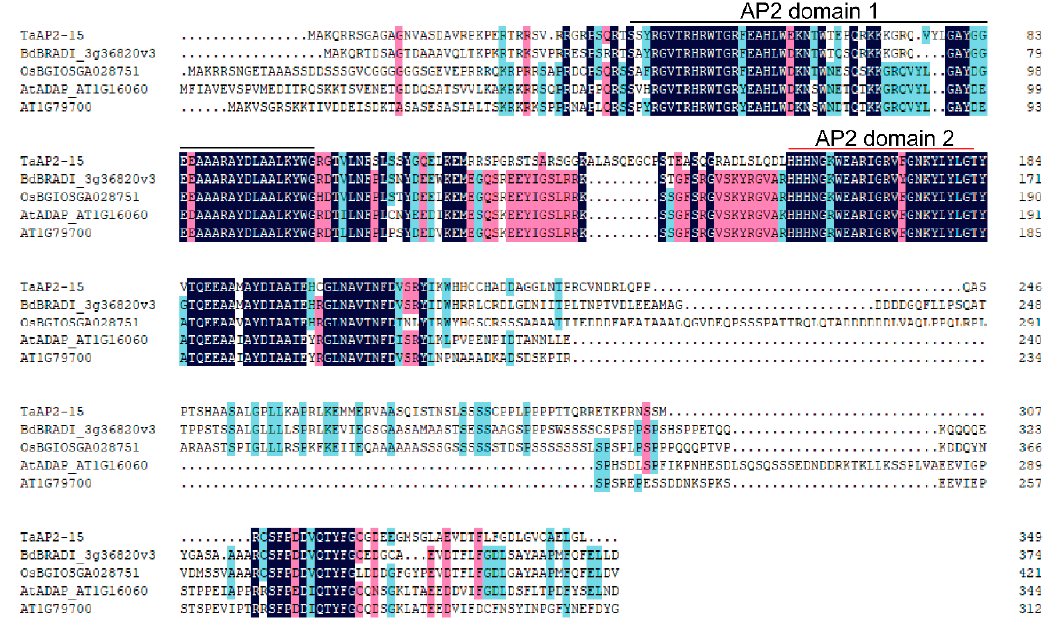
Figure 1. Multisequence alignment of TaAP2-15 with its orthologs in other plant species. Comparison of amino acid sequences of Triticum aestivum ( TaAP2-15 ), with its orthologs from Brachypodium distachyon (BRADI_3g36820v3), Oryza sativum (BGIOSGA028751) and Arabidopsis thaliana (AT1G16060 and AT1G79700). Conserved residues through all organisms are shown in black (100%), pink (75–100%) and light blue (50–75%), respectively. Sequences alignment was performed using DNAMAN8.0 (Lynnon Biosoft, San Ramon, QC, Canada).